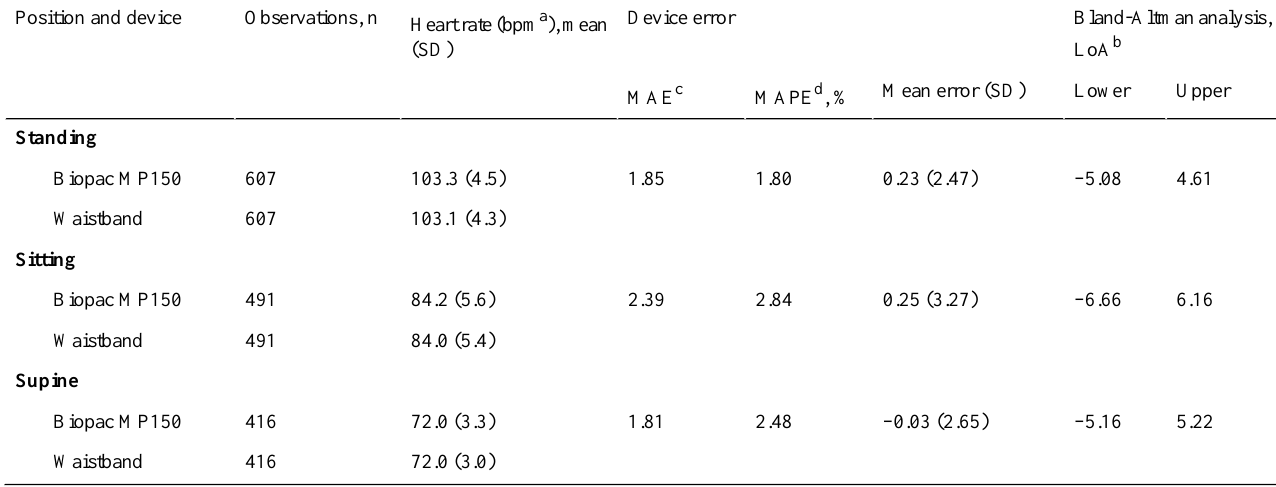
Table 3. Heart rate descriptive statistics, device error statistics, and Bland-Altman analyses comparing Biopac MP150 and waistband-type wireless electrocardiogram measurement systems by